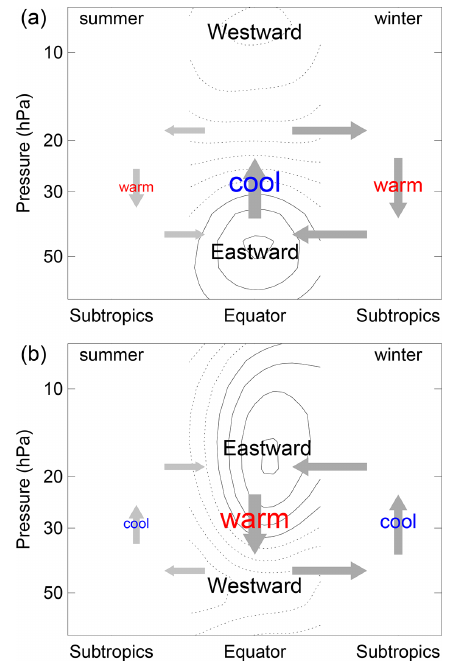
Figure 12. Schematic showing the secondary residual meridional circulation (grey arrows) associated with the QBO equatorial tem- perature anomalies and the asymmetry in the circulation between the summer and winter hemispheres (Peña Ortiz et al., 2008). The locations of the warm and cool anomalies are shown in red and blue, respectively, with the font size giving a qualitative guide to the strength of the anomalies. Solid (dotted) contours indicate east- ward (westward) zonal mean zonal winds at intervals of 10ms − 1 starting at ± 5ms − 1 for (a) westward shear zone and (b) eastward shear zone. After Fig. 1 from Plumb and Bell